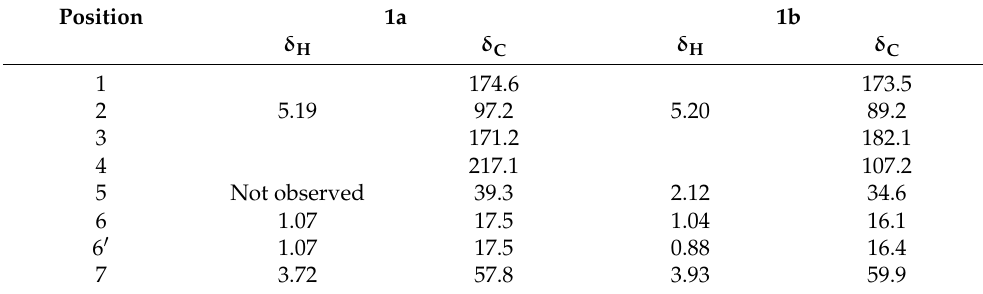
Figure 4. Structures of penicillic acid ( 1 ) and its derivatives ( 1a – 1c ). Table 1. 1 H and 13 C NMR (CD 3 OD) signals observed for crude ( 1a ) and purified ( 1b ) products.